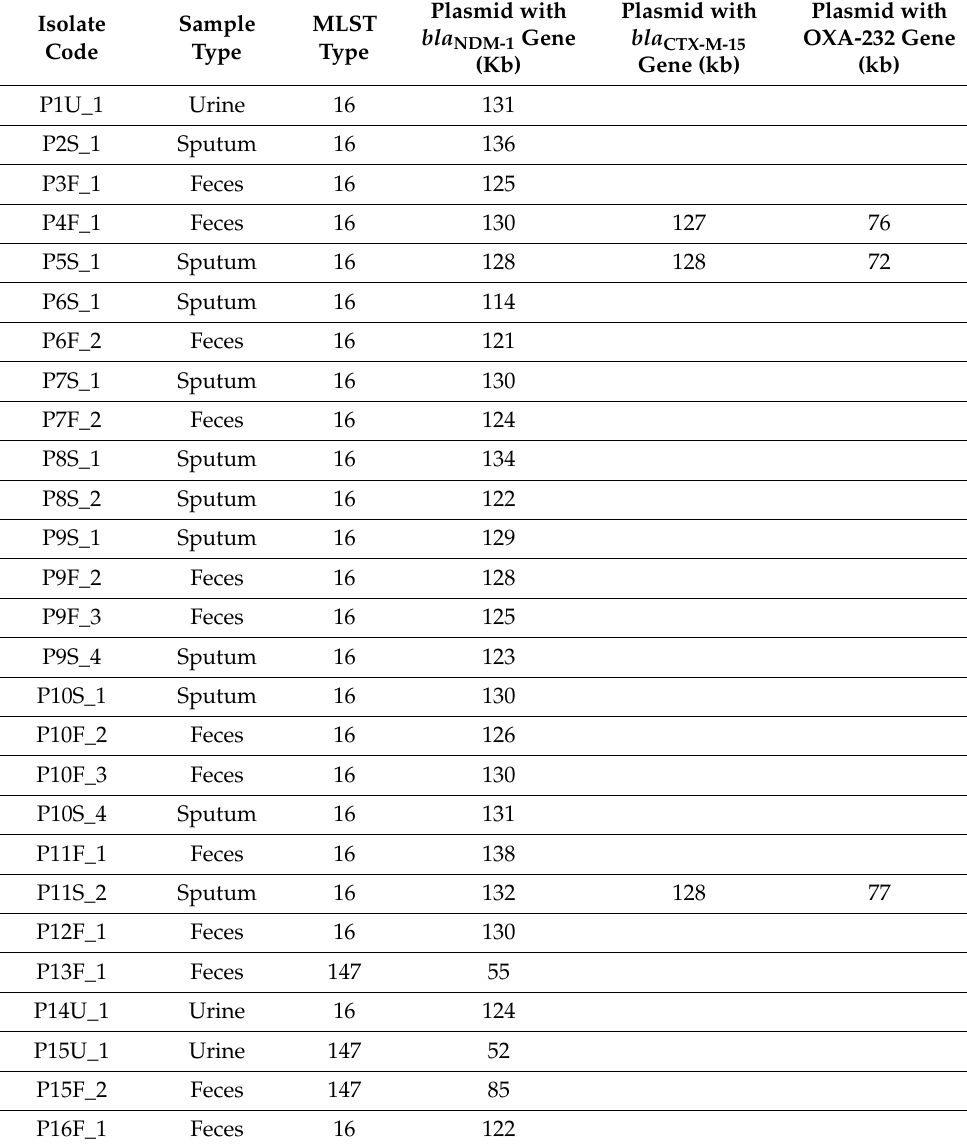
Table 1. Information of K. pneumoniae isolates used in this study. Column 1 shows the isolate code (U = Urine, S = Sputum, F = Feces), column 2 provides information on the source from which the sample was obtained, column 3 shows the multilocus sequence type (MLST) of each isolate, column 4 shows the length of the plasmid (in kb) carrying the bla NDM-1 gene in each isolate studied using ODM, column 5 shows the length of the plasmid (in kb) carrying the bla CTX-M-15 gene in isolates studied using ODM and column 6 shows the length of the plasmid (in kb) carrying the bla OXA-232 gene in isolates studied using